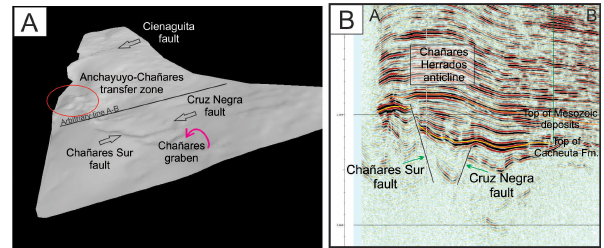
Figure 10. Top of the Cacheuta Formation surface (synrift–sag tran- sition) converted to depth (a) and arbitrary line A–B (b) . Notice the Chañares Sur and Cruz Negra faults preserved as Triassic exten- sional structures, below the Meso–Cenozoic contact. A region with more complicated deformation is named the Anchayuyo–Chañares transfer zone, and it is interpreted as a Triassic transfer zone be- tween the Anchayuyo Norte master fault and Chañares Sur exten- sional fault. The Chañares Herrados anticline is interpreted as a fold generated by strike-slip reactivation of the Chañares Sur